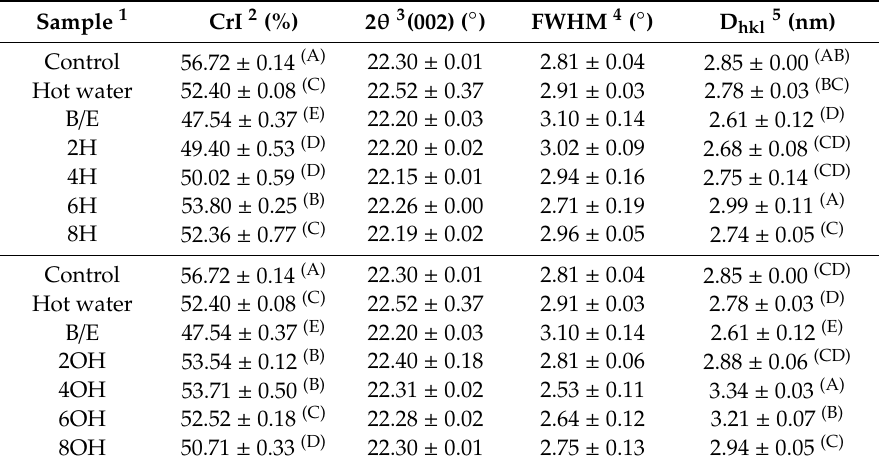
Table 1. Changes in crystallinity index and crystallite size after